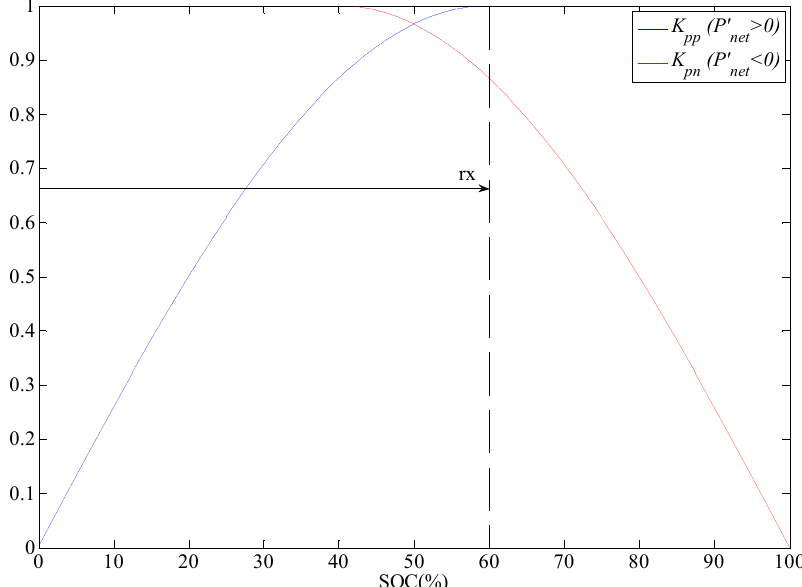
(blue) and K pp pn